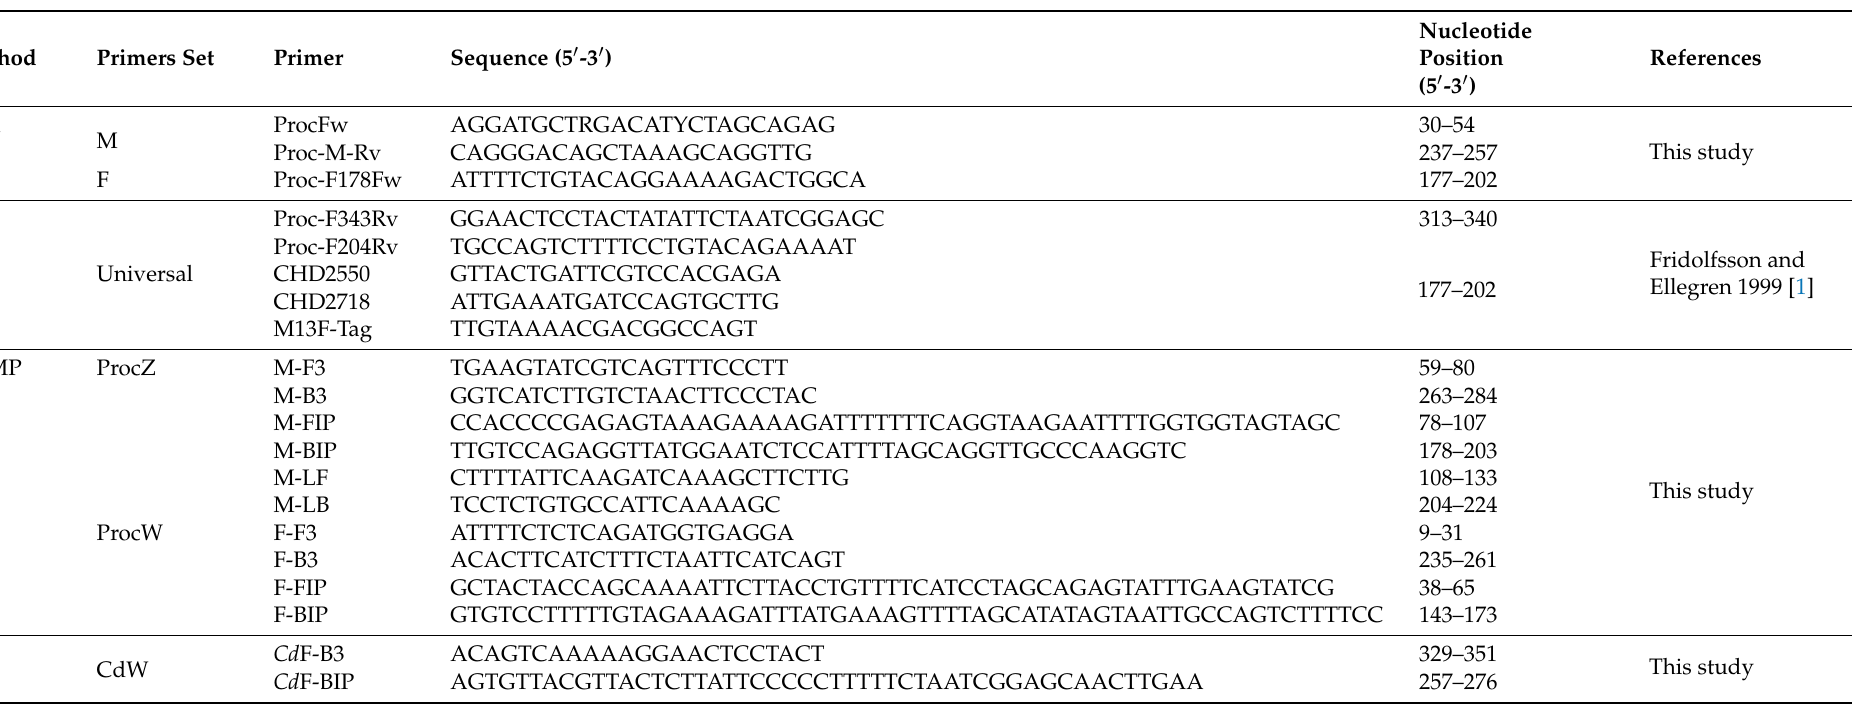
Table 1. Primer sets used in the study to amplify CHD-Z and CHD-W of three Mediterranean Procellariforms ( Calonectris diomedea, Puffinus yelkouan, Hydrobates pelagicus ) by PCR (M and F primer set) and LAMP (ProcZ and ProcW primer set) methods. M and F set were used for male and female-specific reaction, respectively. ProcZ occurs in both males and females, ProcW occurs only in females. Nucleotide positions are based on C. diomedea CHD-Z and CHD-W